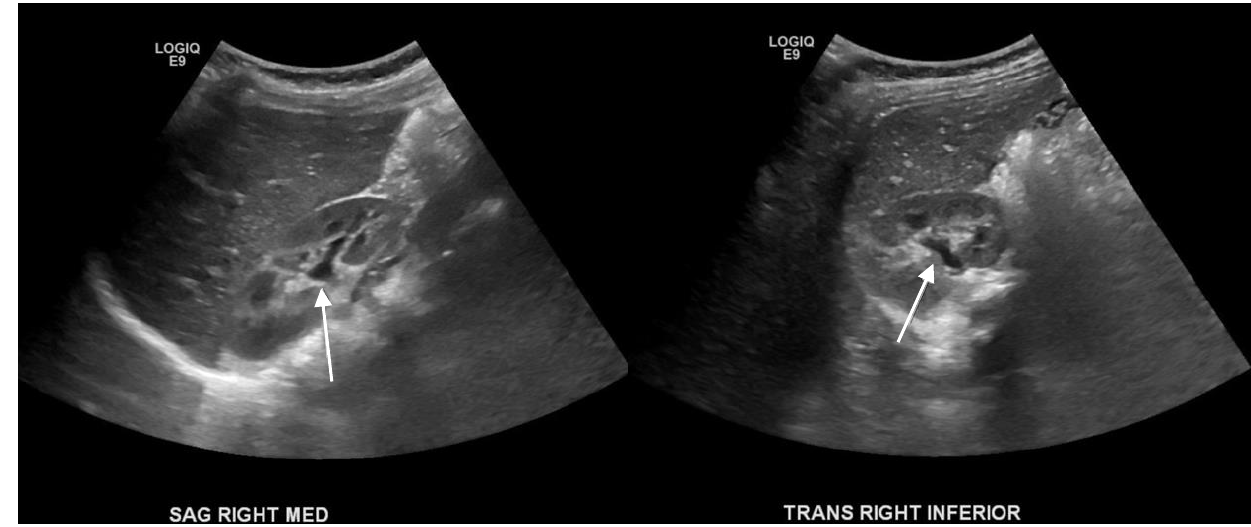
Figure 1. Ultrasound of right kidney demonstrating hydronephrosis (white